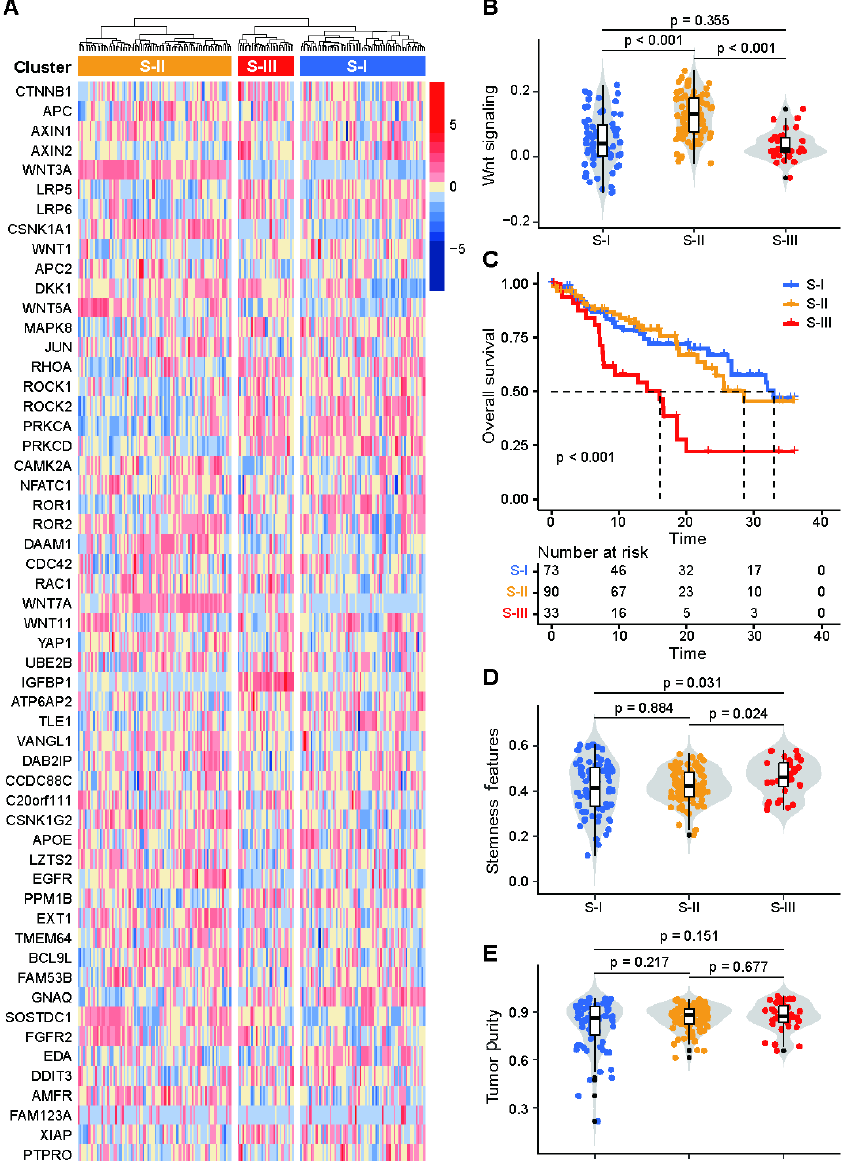
Figure 1. Tumor clustering based on WNT signaling. ( A ) WNT signaling-related genes were used for unsupervised hierarchical clustering to classify the 196 patients in the cohort from TCGA into 3 clusters: Clusters 1, 2 and 3; ( B ) ssGSEA revealed significant activation of WNT signaling in Cluster 2, significant inhibition in Cluster 3, and no significant change in Cluster 1; ( C ) Kaplan–Meier survival analysis suggested that Cluster 3 had the worst prognosis and Clusters 1 and 2 had a similar prognosis; ( D ) Stemness feature analysis showed that Cluster 3 had the highest stemness features and Clusters 1 and 2 had similar stemness features; ( E ) No difference in tumor purity between clusters was